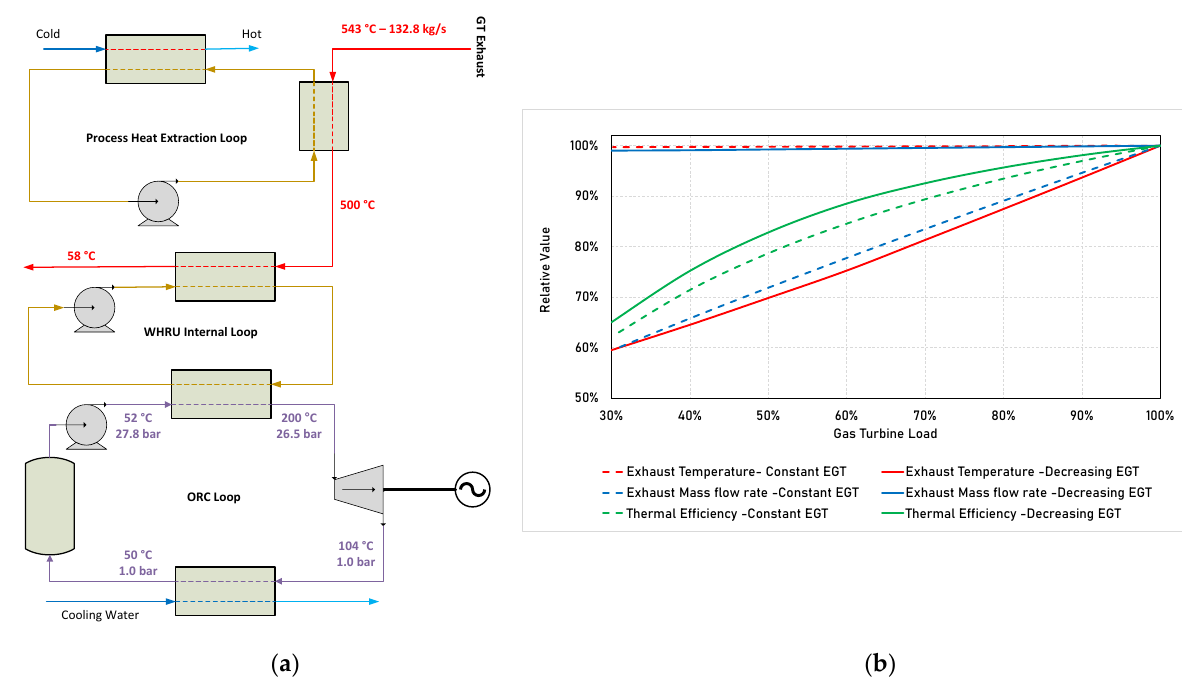
Figure 1. System characteristics: ( a ) Cycle flow diagram; ( b ) Gas turbine part-load performance.